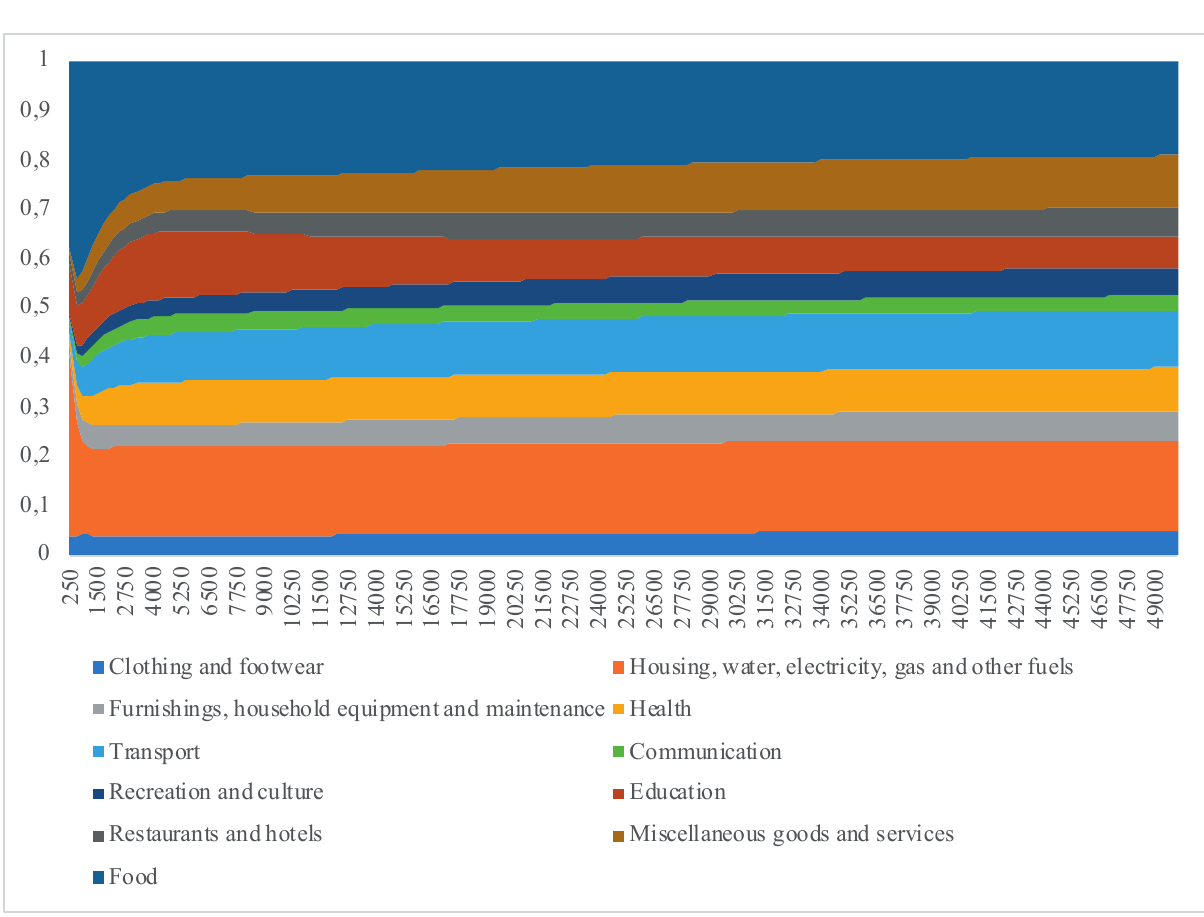
Figure 3. Simulated expenditure shares, non-food items and total for food. Note: Calculated at mean sample prices and mean sample values of the additional